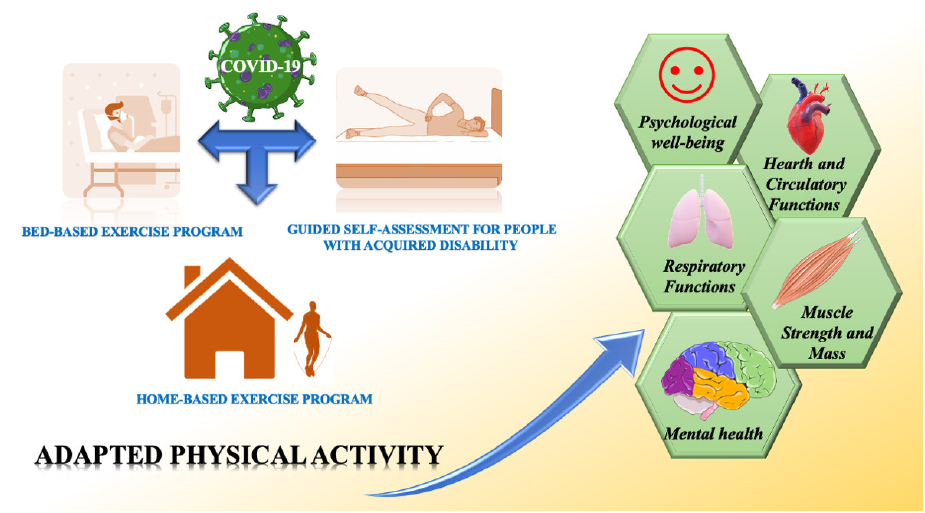
Figure 1. Health benefits from regular adapted physical activity in COVID-19-affected patients.